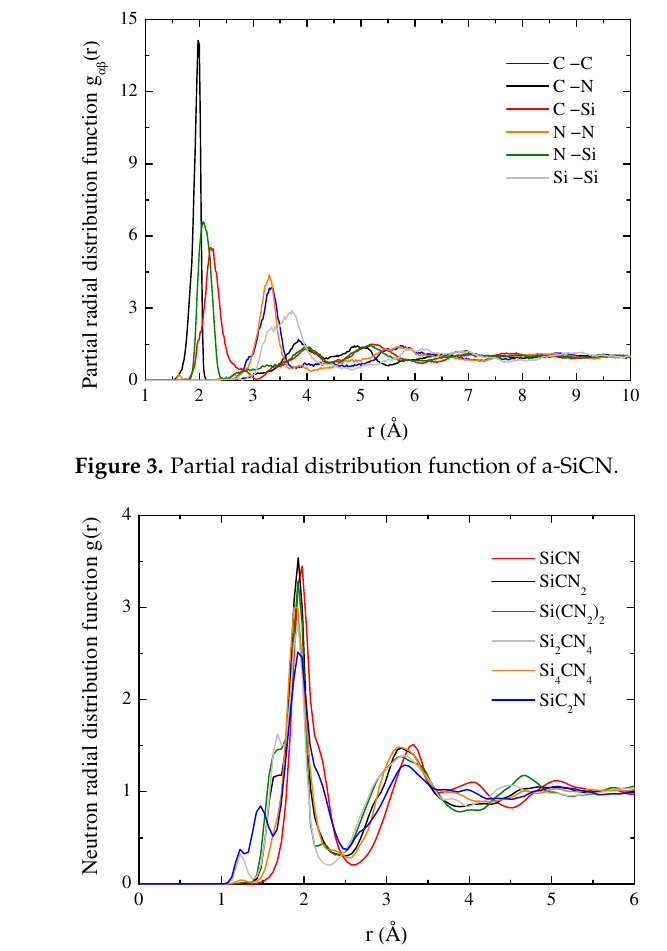
Figure 4. Neutron radial distribution function of a-SiC x N y . The structure is assessed by calculating the total structure factors S(q) for a-SiC x N y with different atom content from neutron scattering, as shown in Figure 5. The distinct peaks are observed at about 2.5 and 4.2 Å, similar to the S(q) results performed by neuron wide angle scattering experiments of amorphous Si 37 C 32 N 31 [23]. The mechanical proper- ties are considered in the forthcoming sections based on the good agreement between the experimental and simulated structural characteristics in the density and structure factors.